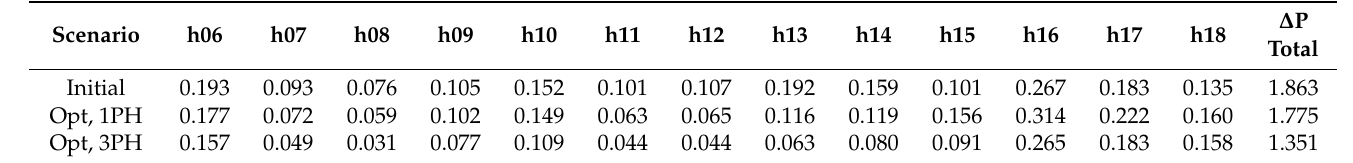
Figure 18. Actual bus demand in network R121 (aggregated demand and generation)—three-phase PSM.